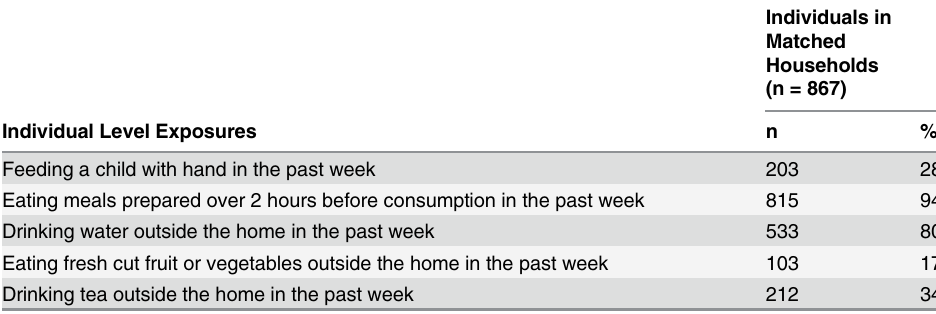
Individuals in Matched Households (n = 867)